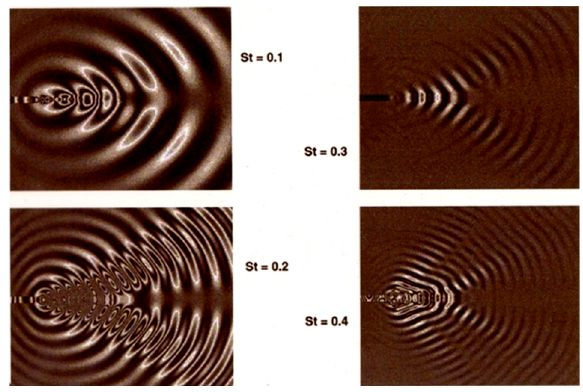
Figure 17. Very large-eddy simulation. Zones of the governing equation (Ref. [58,62]).